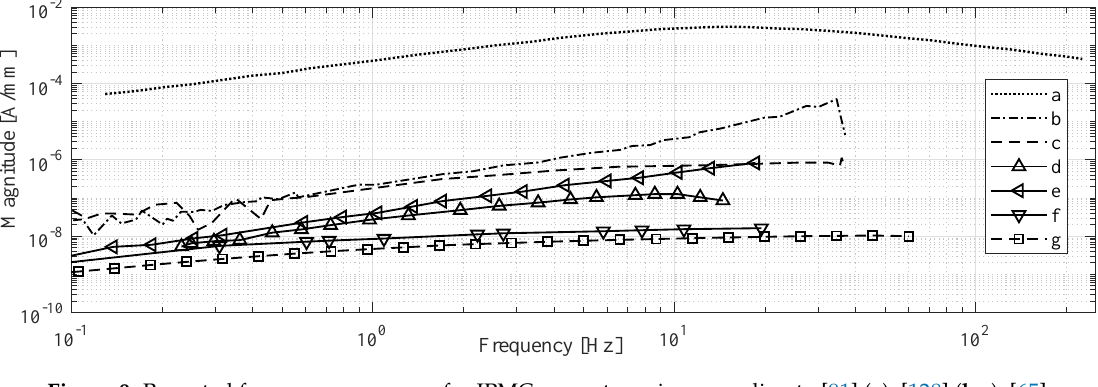
Figure 9. Reported frequency responses for IPMC current sensing according to [91] ( a ), [128] ( b , c ), [65] ( d , e , f ), and [133] ( g